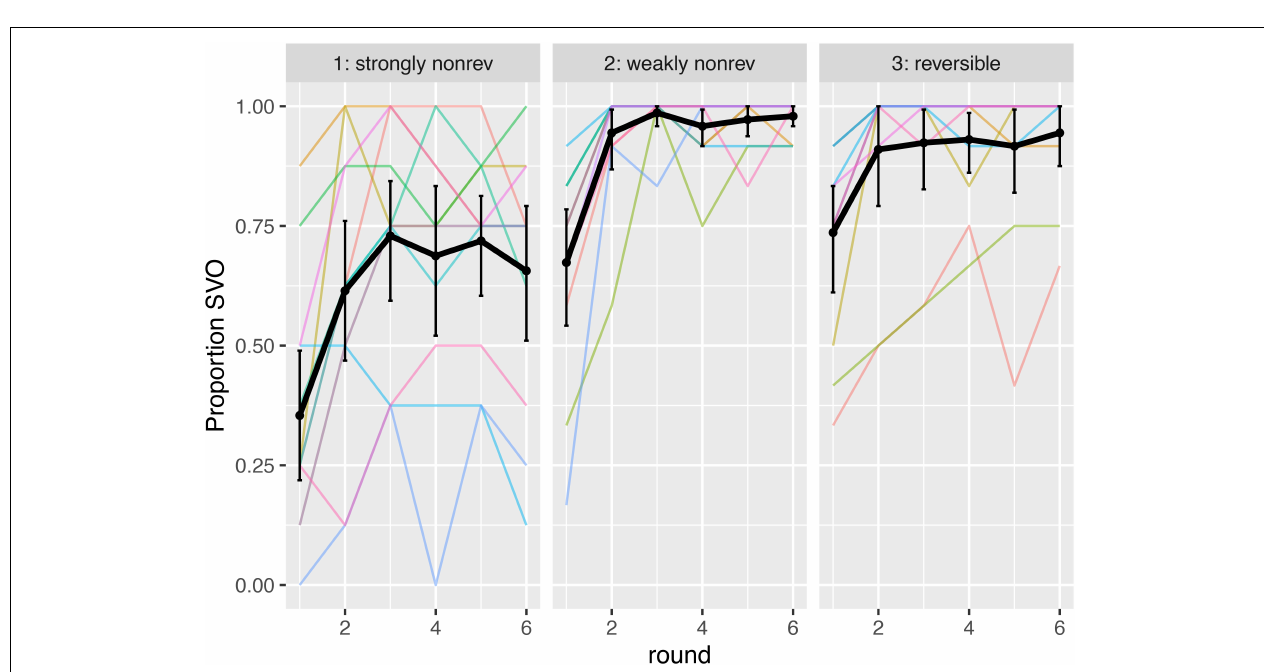
FIGURE 7 | Proportion SVO order by round, for each of the three event types. Black line represents mean, error bars 95% CIs, and colored lines dyads.